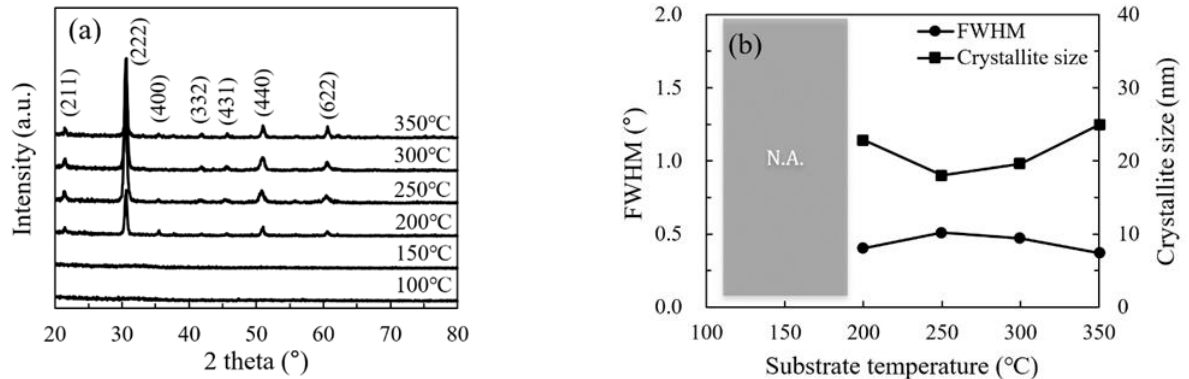
Figure 4. ( a ) The grazing incident X-ray diffraction (XRD) patterns of In 2 O 3 films deposited at different substrate temperatures; ( b ) variation of full width at half maximum (FWHM) for the (2 2 2) peak and the size of the (2 2 2)-orientated crystallites with substrate temperature. N.A. is the abbreviation for not available.